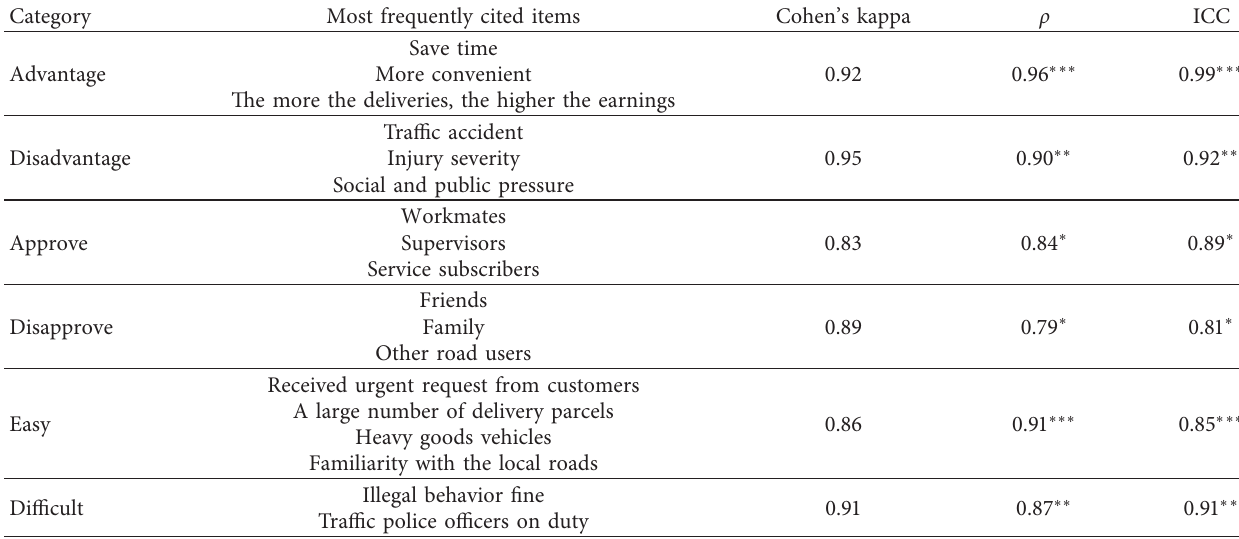
Table 1: Consistency and correlations of